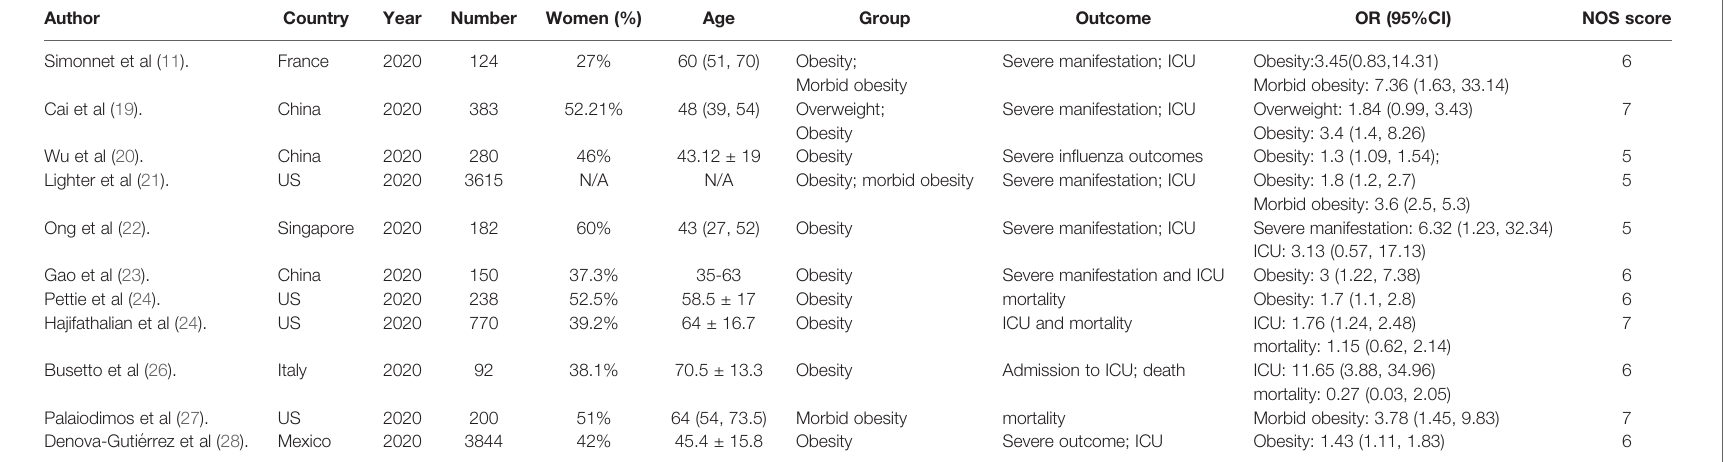
TABLE 2 | Characteristics of included studies on the severity and mortality of COVID-19.